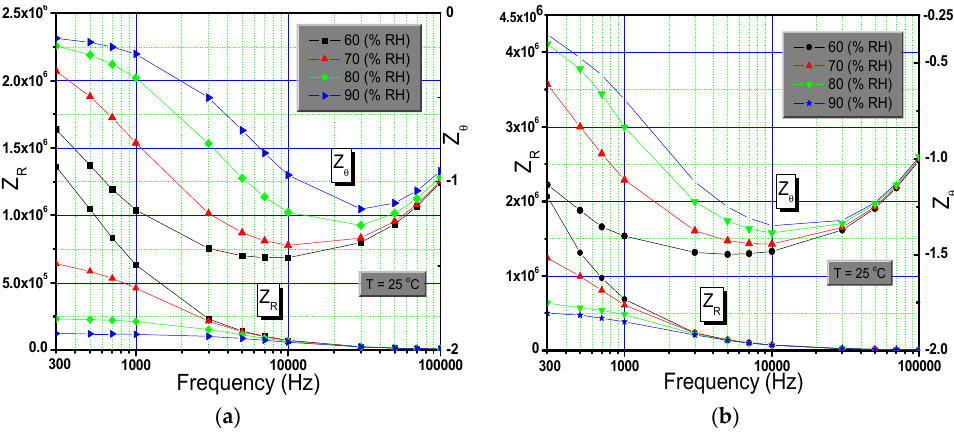
Figure 4. The variation of real component of impedance and phase angle (as a function of humidity at varied frequencies) of the sensors with ( a ) interdigitated and ( b ) rectangular (Ag) electrodes configuration respectively.